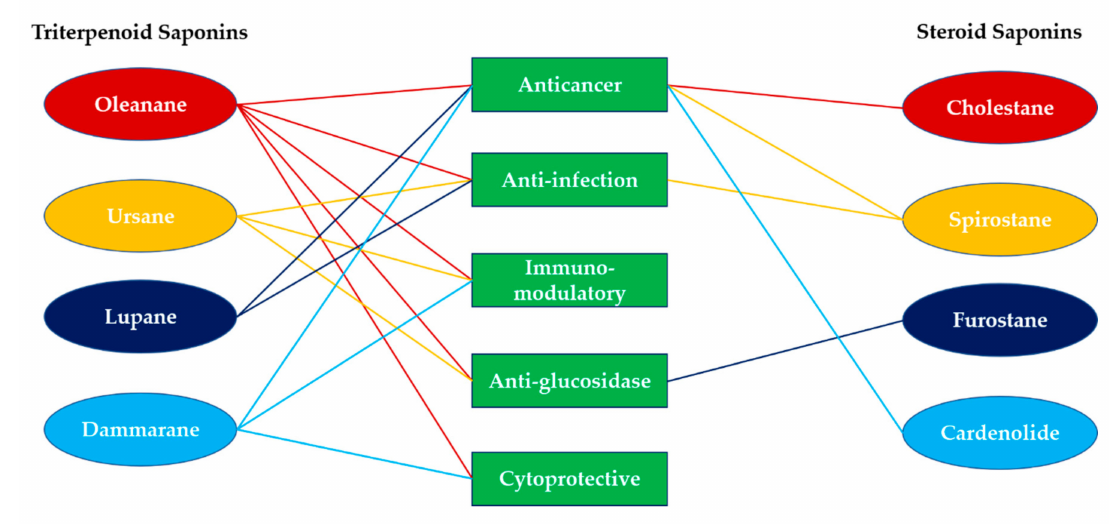
Figure 6. Summary of the biological and pharmacological activities of synthetic